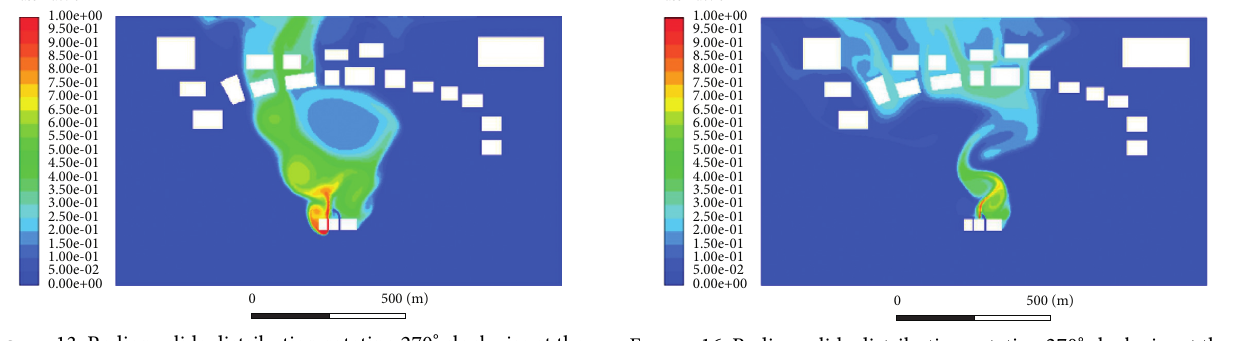
Figure 16: Radionuclide distribution rotating 270 ° clockwise at the western break.